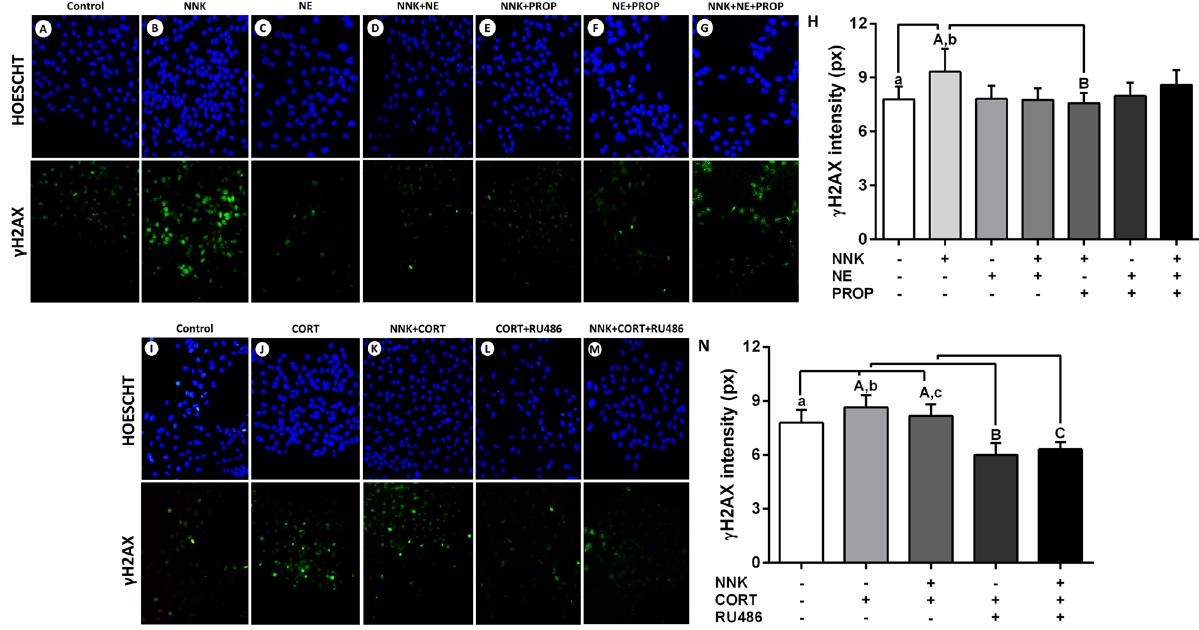
Figure 4. Exposure to the NNK and norepinephrine and γH2AX nuclear expression in oral keratinocytes. ( A ) Control. ( B ) NNK. ( C ) Norepinephrine. ( D ) NNK and norepinephrine. ( E ) NNK and propranolol. ( F ) Norepinephrine and propranolol. ( G ) NNK, norepinephrine and propranolol. ( H ) NNK increased the γH2AX nuclear expression levels. Beta-blocker propranolol inhibited the increased DNA damage caused by the carcinogen. Cortisol increased the γH2AX nuclear expression in oral epithelial cells. ( I ) Control. ( J ) Cortisol. ( K ) NNK and cortisol. ( L ) Cortisol and RU486. ( M ) NNK, cortisol and RU486. ( N ) Cortisol increased the γH2AX nuclear expression levels in the presence or absence of carcinogen NNK. Glucocorticoid receptor blocker RU486 inhibited the increased DNA damage caused by the hormone. The results are expressed as the mean ± standard deviation (SD). Upper- and lower cases equal letters indicate a statistically significant difference ( p < 0.0001). NNK = 4 (N-metil-N-nitrosamine)-1-(3-piridil)-butano-1-one). NE = norepinephrine. PRO p = propranolol. CORT = cortisol. NNK, NE, PROP and RU486 were used at 10 µM. CORT was used at 100 nM. NOK-SI cells were exposed to NNK and/or stress hormones in the presence or absence of their antagonists for 72